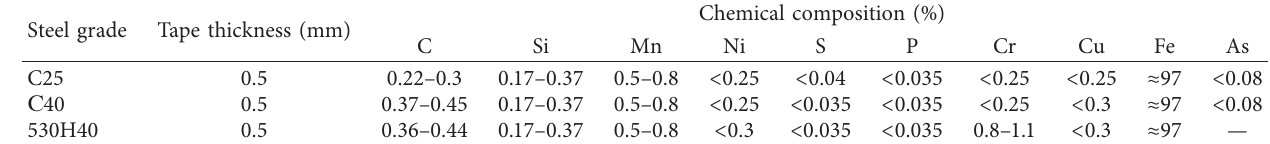
Table 1: Metal tapes for electric surfacing.